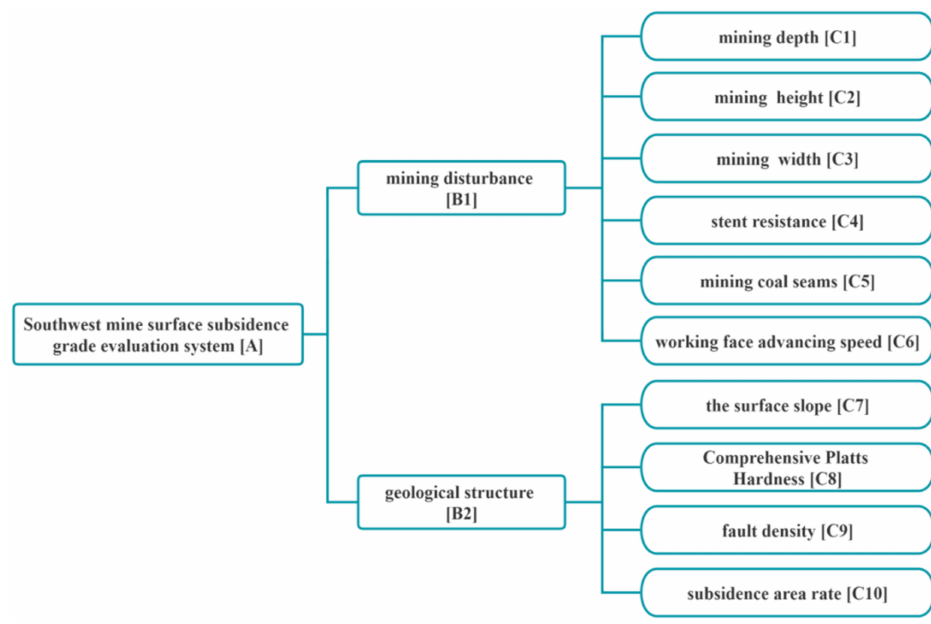
Figure 1. Evaluation system for surface subsidence grades in southwest mines. Table 1. Classification of evaluation indexes of mine surface